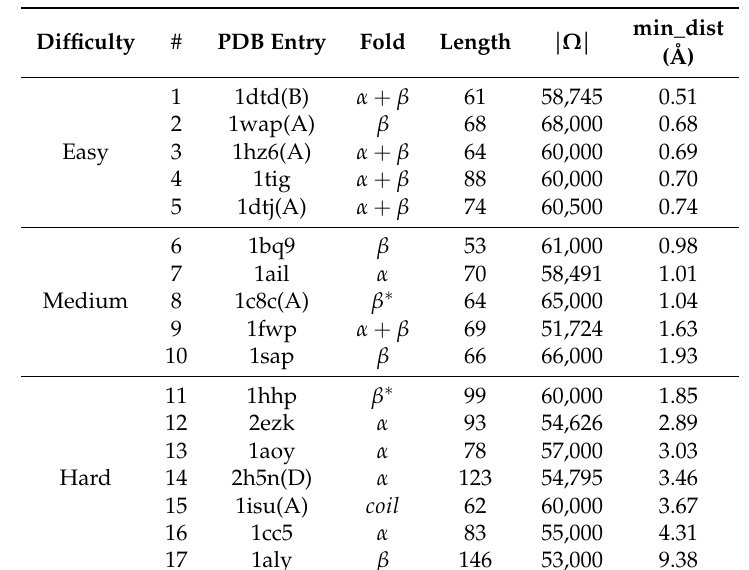
Table 1. Testing dataset (* denotes proteins with a predominant β fold and a short helix). Protein Data Bank entries of corresponding known native structures are shown in Column 3. Folds of native structures are shown in Column 4. The length of each sequence (number of amino acids) is shown in Column 5. The size of the Rosetta-generated decoy dataset (number of decoys) is shown in Column 6. The lowest root-mean-squared-deviation to the known native structure in each dataset is shown in Column 7. As described above, based on this proximity, the datasets are categorized into easy, medium-difficulty, and